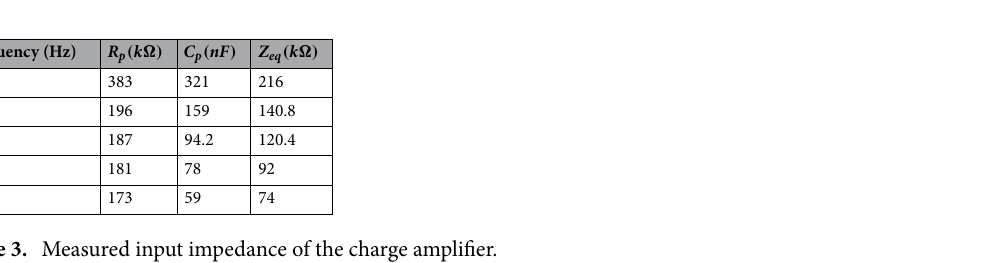
Table 3. Measured input impedance of the charge amplifier.